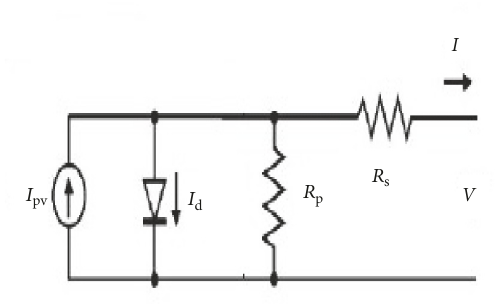
Figure 3: Single-diode model of the theoretical PV cell and equivalent circuit of a practical PV device including the series and parallel